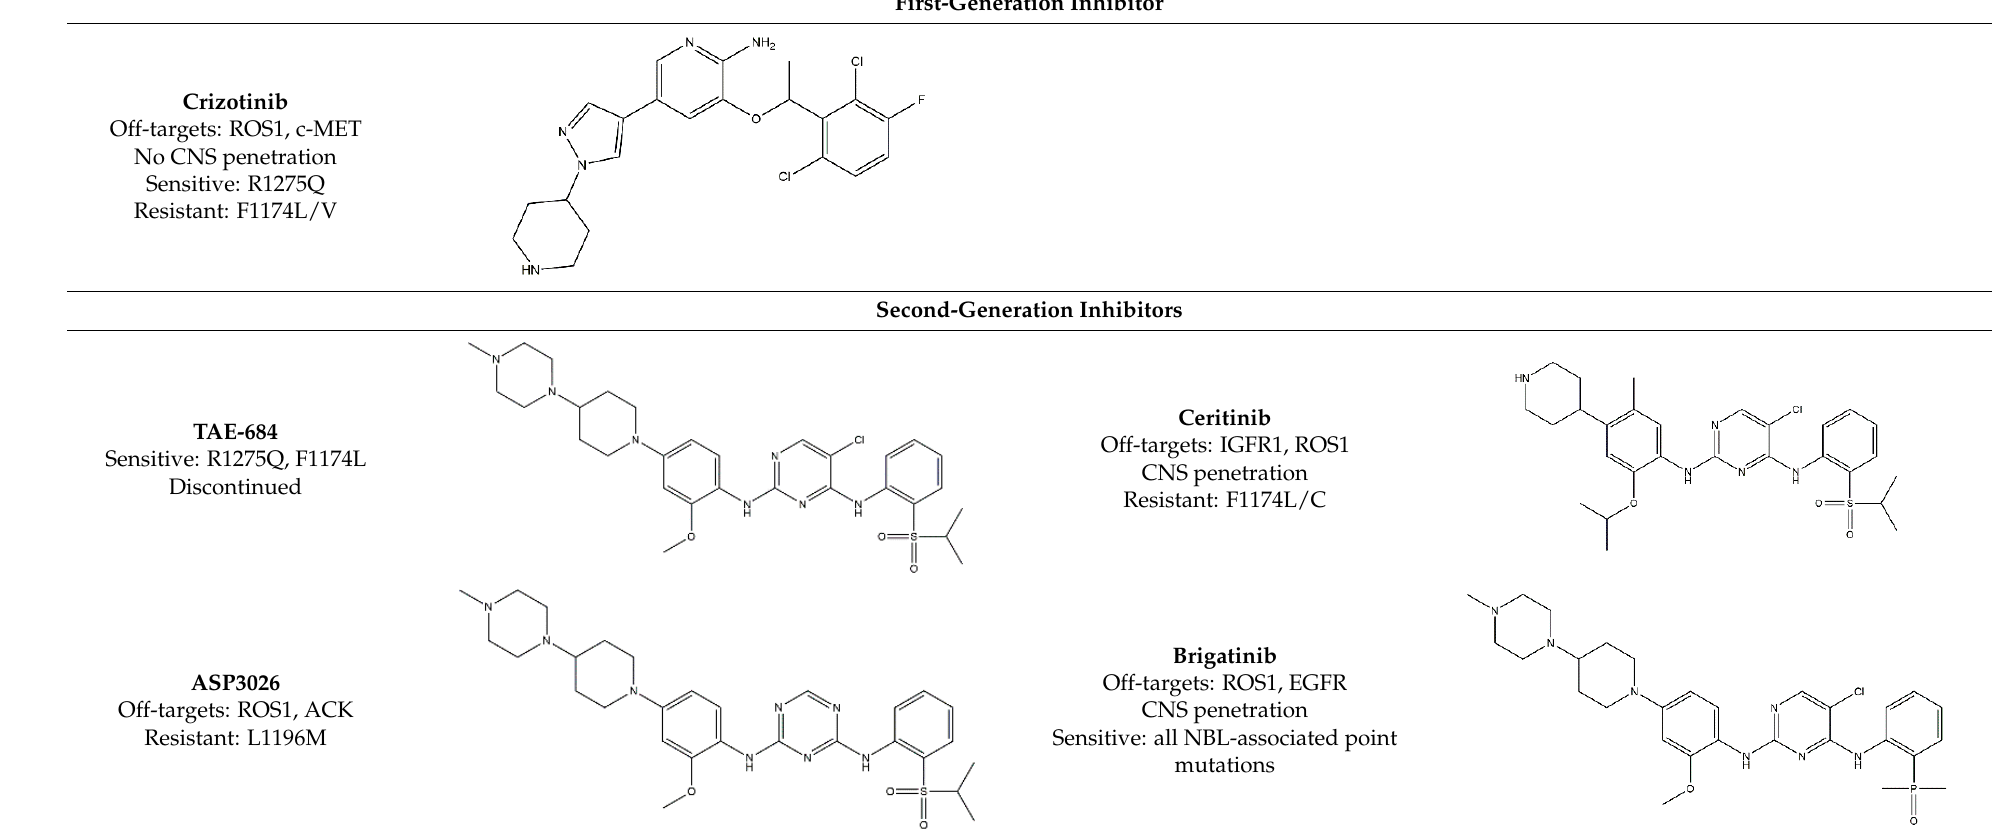
Table 2. Characteristics and structures of first-, second-, and third-generation of anaplastic lymphoma kinase inhibitors